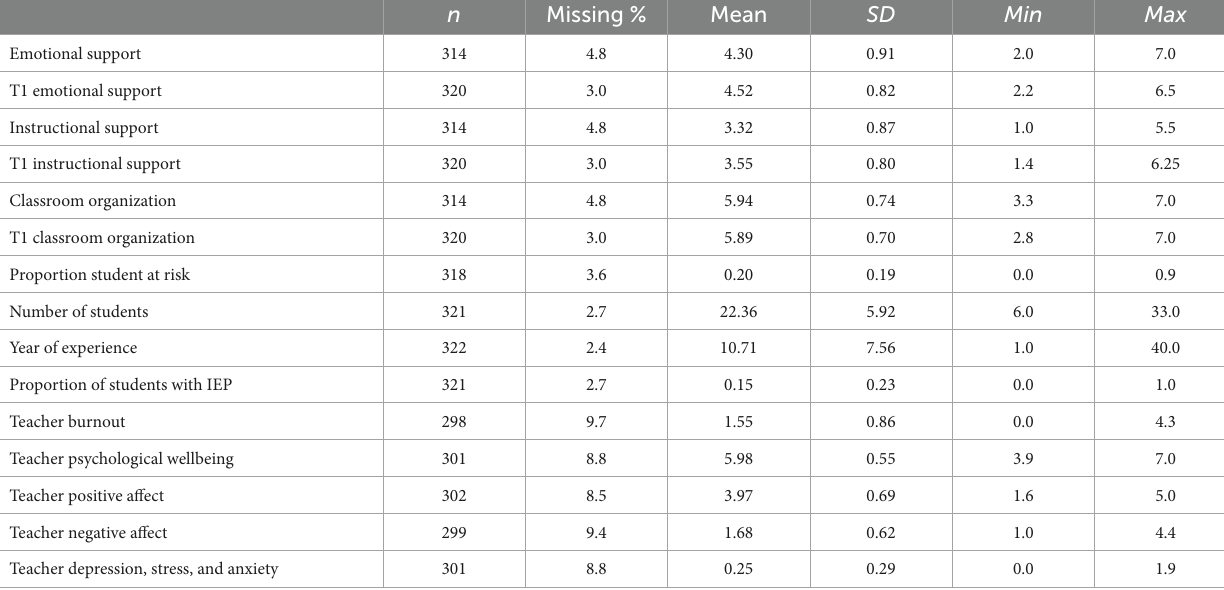
TABLE 6 Descriptive statistics of classroom and teacher